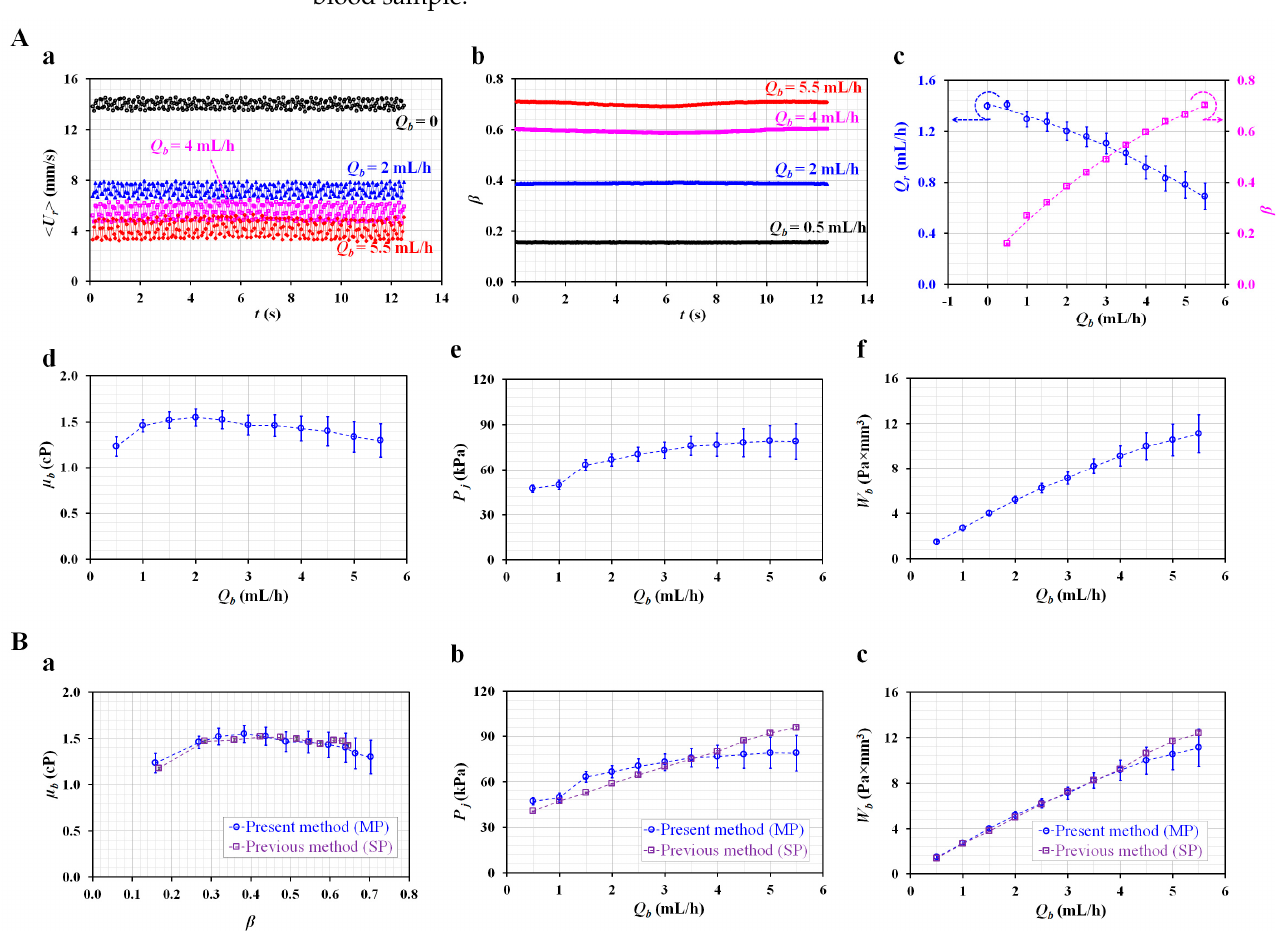
Figure 4. Quantitative evaluation of three biophysical properties (i.e., viscosity, junction pressure, and pressure-induced work) under a constant flow rate of the blood sample. ( A ) Quantitative evaluation of blood biophysical properties under constant blood flow set by a syringe pump. ( a ) Temporal variations of < U r > with respect to Q b = 0, 2, 4, and 5.5 mL/h. ( b ) Temporal variations of β with respect to Q b . ( c ) Variations of Q r and β with respect to Q b . ( d ) Variations of µ b with respect to Q b . ( e ) Variations of P j with respect to Q b . ( f ) Variations of W b with respect to Q b . ( B ) Quantitative compar- ison between the present method and previous method. ( a ) Comparison of µ b with respect to β . ( b ) Comparison of P j with respect to Q b . ( c ) Comparison of W b with respect to Q b .